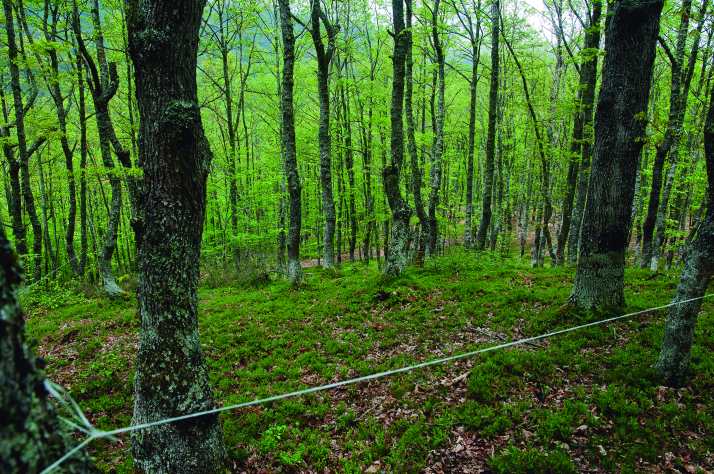
P1 plot Monte Robledo, Quercus
petraea forest